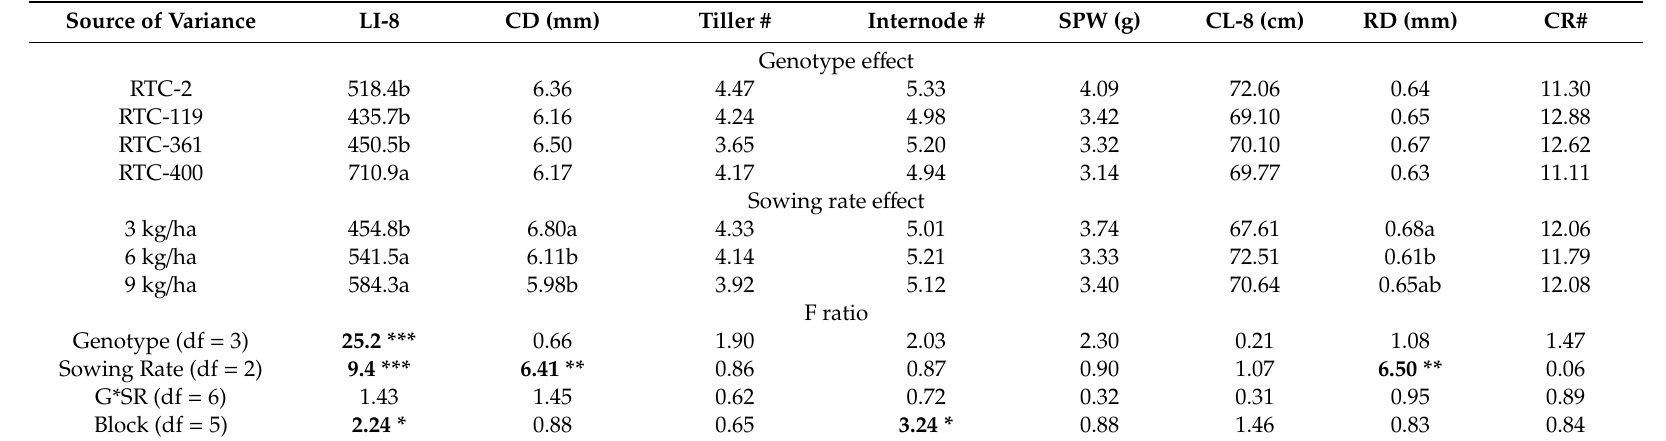
Table 4. E ff ects of genotype and sowing rate on lodging and related morphological traits assessed 8 weeks after emergence in the 2019 experiment: lodging index (LI-8), crown diameter (CD), tiller number (Tiller # ), internode number (Internode #), single-plant dry weight (SPW), culm length (CL-8), root diameter (RD), and number of crown roots